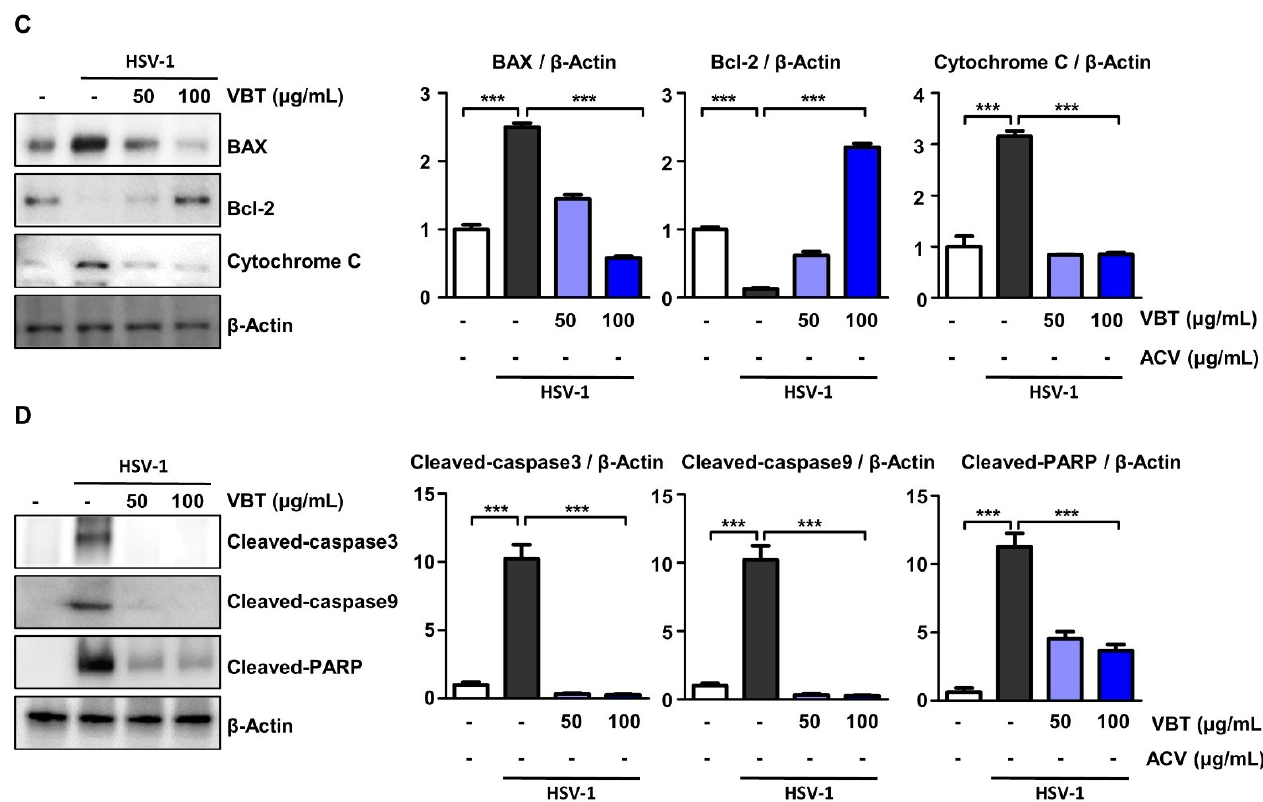
Figure 6. Protective effect of VBT against HSV-1 induced apoptosis in SK-N-SH cells. SK-N-SH cells were infected with HSV-1 at MOI = 0.1 for 2 h. Then, the infectious agent medium was removed and replaced with fresh medium, and VBT was added at 50 μ g/mL or 100 μ g/mL for 48 h. ( A ) The expression of genes that were involved in DRs makers following HSV-1 infection was measured using Western blot analysis. ( B ) Live/Dead cell staining of SK-N-SH cells. The green color represents live cells and the red color represents dead cells. Images were measured at 200 × ratio using a fluorescence microscope. ( C , D ) The expression of genes that are involved in apoptosis makers following HSV-1 infection was measured using Western blot analysis. The expression of these proteins was normalized to that of β -Actin as a relative ratio. *** p < 0.001 vs. HSV-1 treatment